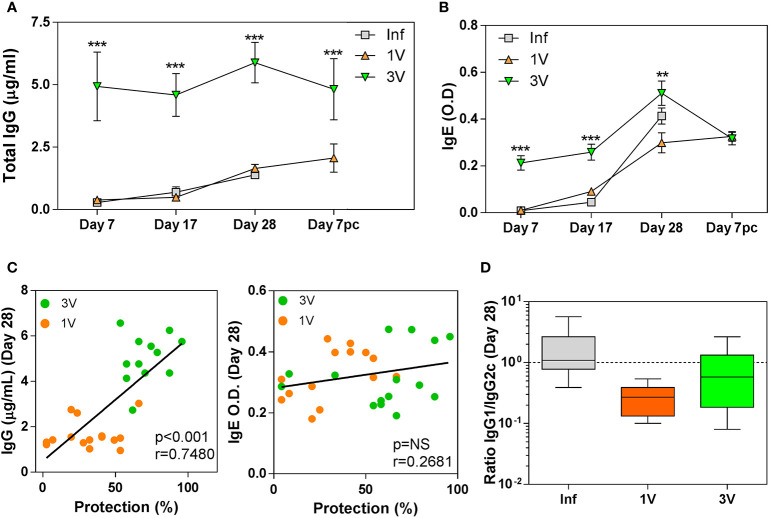
Antibody levels in serum of vaccinated/infected mice: (A) Total schistosome-specific IgG antibody and (B) IgE in 1V, 3V and Inf at Days 7, 17 and 28 plus Day 7 pc; asterisks indicates significant differences in relation to the Infected group (Inf), ANOVA followed by Tukey’s post-hoc test (**p < 0.01, ***p < 0.001). (C) Correlation analysis of total schistosome-specific IgG and total IgE at Day 28 with worm burden at experiment termination in the immunized groups (D) Box-plot and whisker graph representing the lower and upper quartiles, median and minimum- maximum values for IgG1/IgG2c ratios in the serum of immunized mice at Day 28. Data derived from cross-Sectional➀ for (A, B) (six mice per group per time point) and derived from longitudinal assay➁ (15 mice per experimental group) for (C, D).